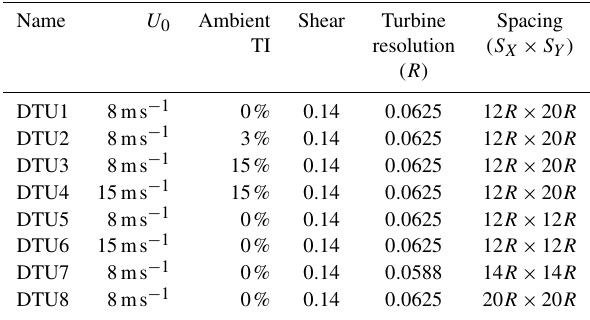
Table 2. Overview of simulations performed by DTU. The simula- tions include 16 turbines and 60min of data.